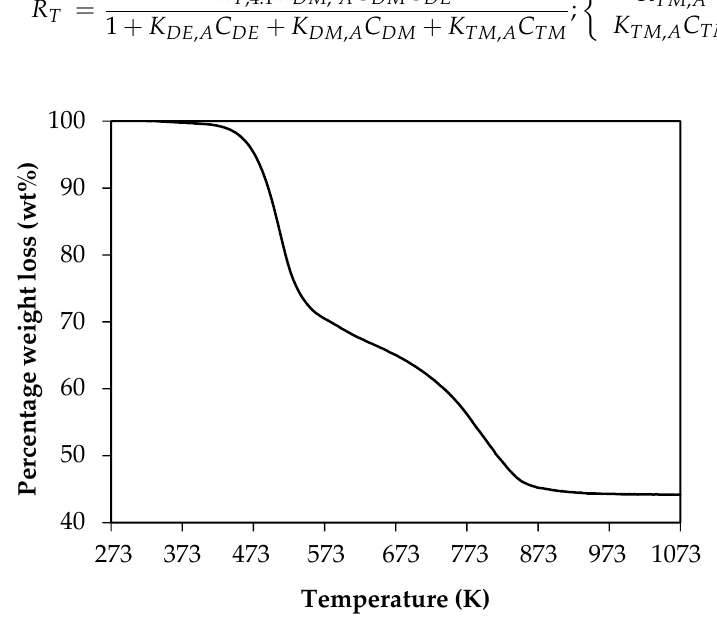
Figure 4. Decomposition of spent HY catalyst at 483 K based on TGA method.